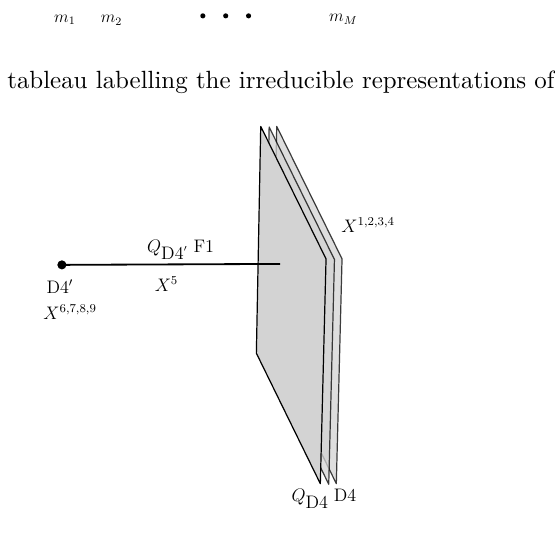
Figure 4 . Wilson loop in the Q D 4 0 -th antisymmetric representation of U ( Q D4 )